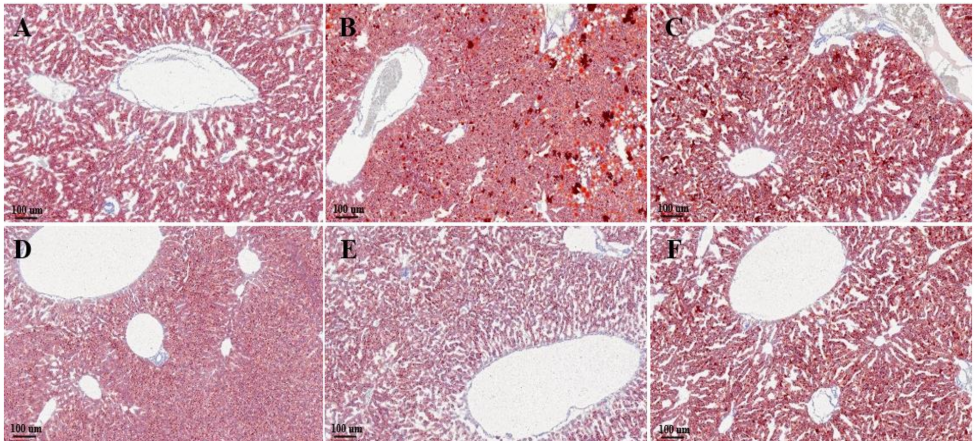
Figure 7. Oil Red O staining of mouse liver tissue treated without or with EPPH. EtOH-induced liver steatosis model mice were orally administered with ( A ) vehicle (saline, normal group), ( B ) control group, ( C ) 1.03, ( D ) 3.08, ( E ) 9.23 mg/kg BW of EPPH, respectively, and ( F ) 200 mg silymarin/kg BW as positive control on a daily basis. After 42 days of treatment, the hepatic steatosis was measured by Oil Red O staining. Magnification = ×